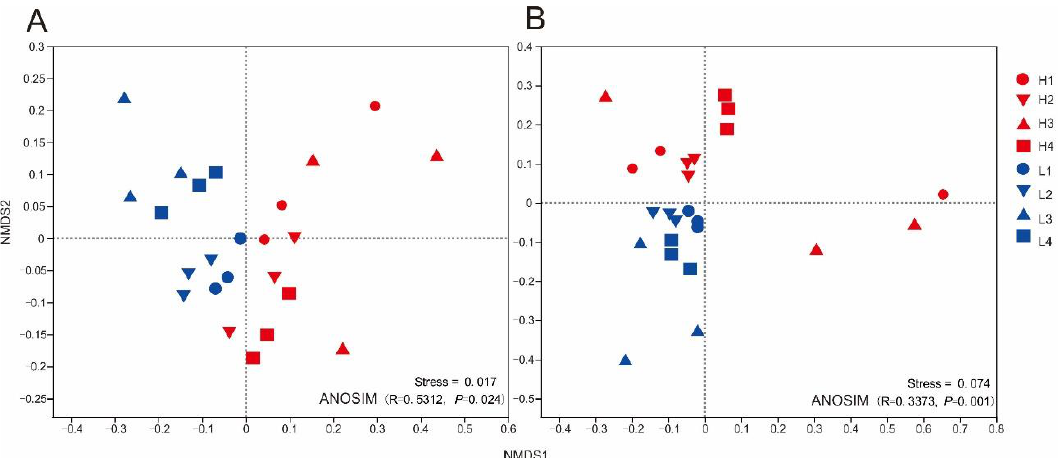
Figure 3. Non-metric multidimensional scaling (NMDS) of soil microbial communities based on pairwise UniFrac distance matrices. ( A ) Bacteria and ( B ) fungi: The consistency of the new model was determined by the stress value with the original data. Non-parametric ANOSIM (analysis of similarities) indicated significant differences between soil microbial community structure across elevations on Wuyi Mountain. L1, L2, L3, and L4 correspond to forests at low elevations and H1, H2, H3, and H4 correspond to forests at high elevation levels, respectively.